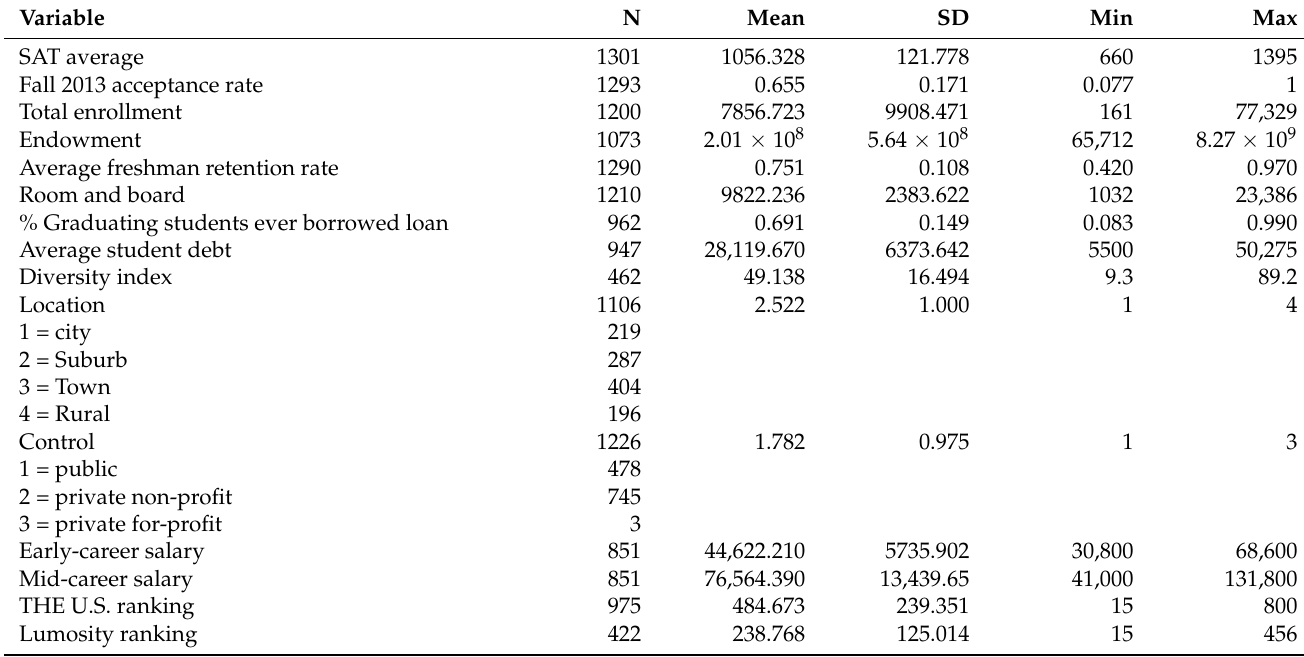
Table A2. Summary statistics from U.S. News